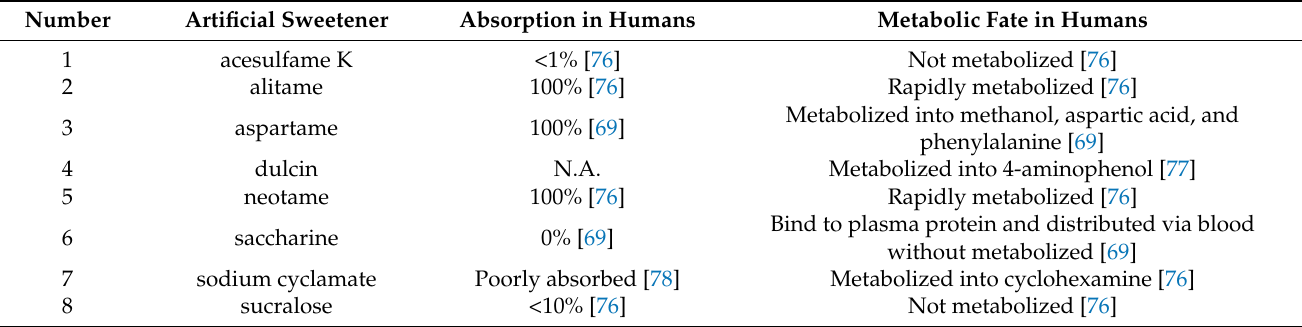
Table 3. Absorption and metabolic fate of the eight artificial sweeteners used in the